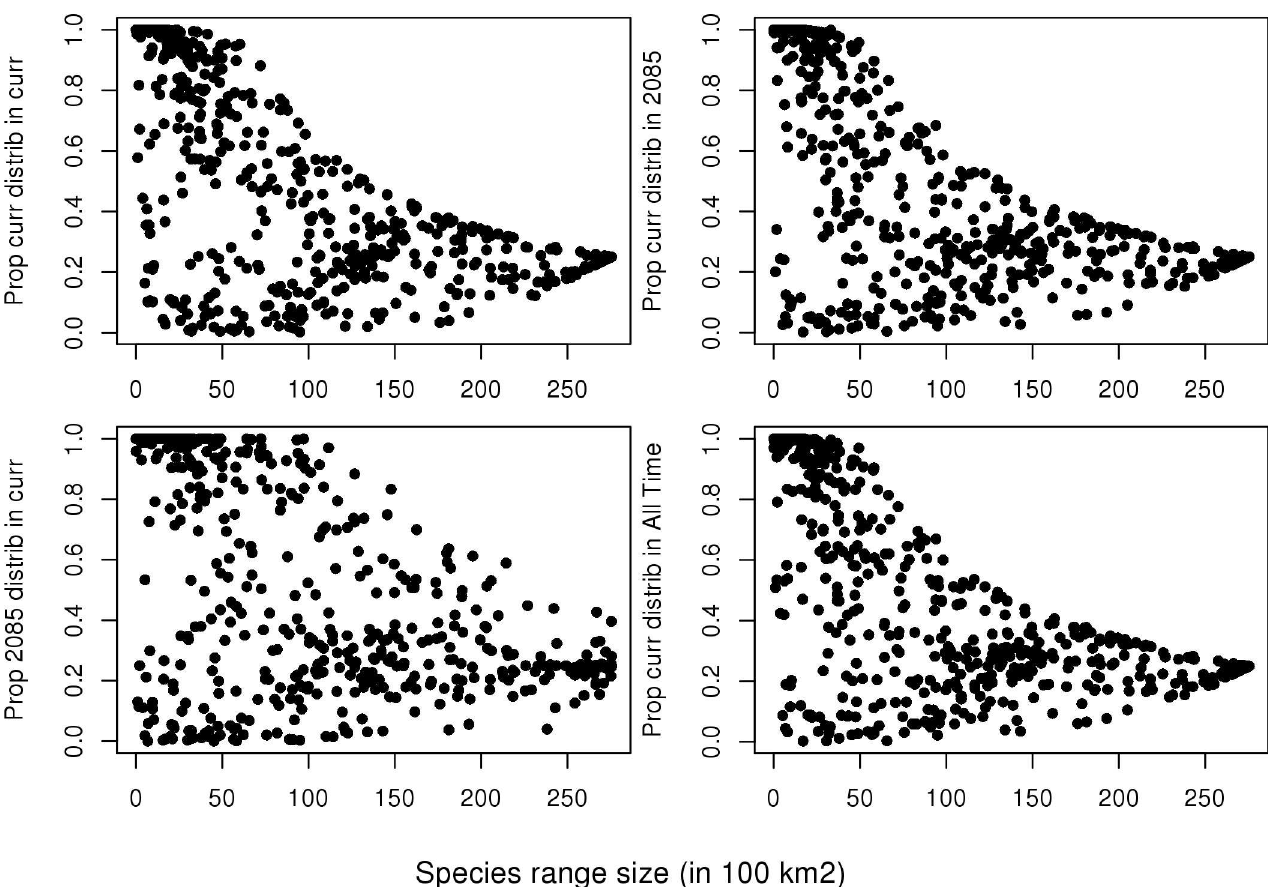
Fig 3. The proportion of species distributions captured by the top 25% of the different solutions plotted against their range size within the region. Top row: 1) proportionof species current distribution within the Current solution,2) proportionof species current distributionwithin the 2085solution. Bottom row: 1) proportionof species2085 distributionwithin the Current solution, 2) proportionof species current distribution within the All Time solution.